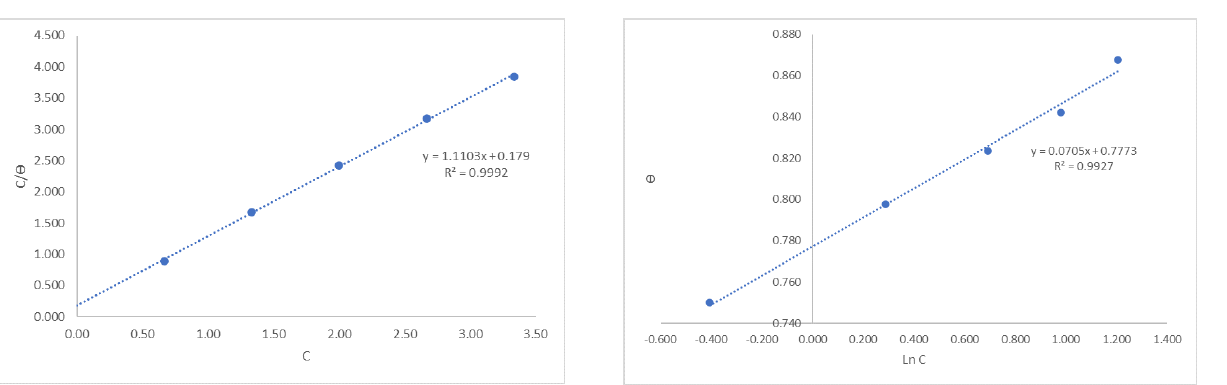
Fig. 8. Langmuir isotherm plot for the inhibitor’s adsorption of CPP on mild steel surface in 1.0 M HCl at 24 hour immersion time.